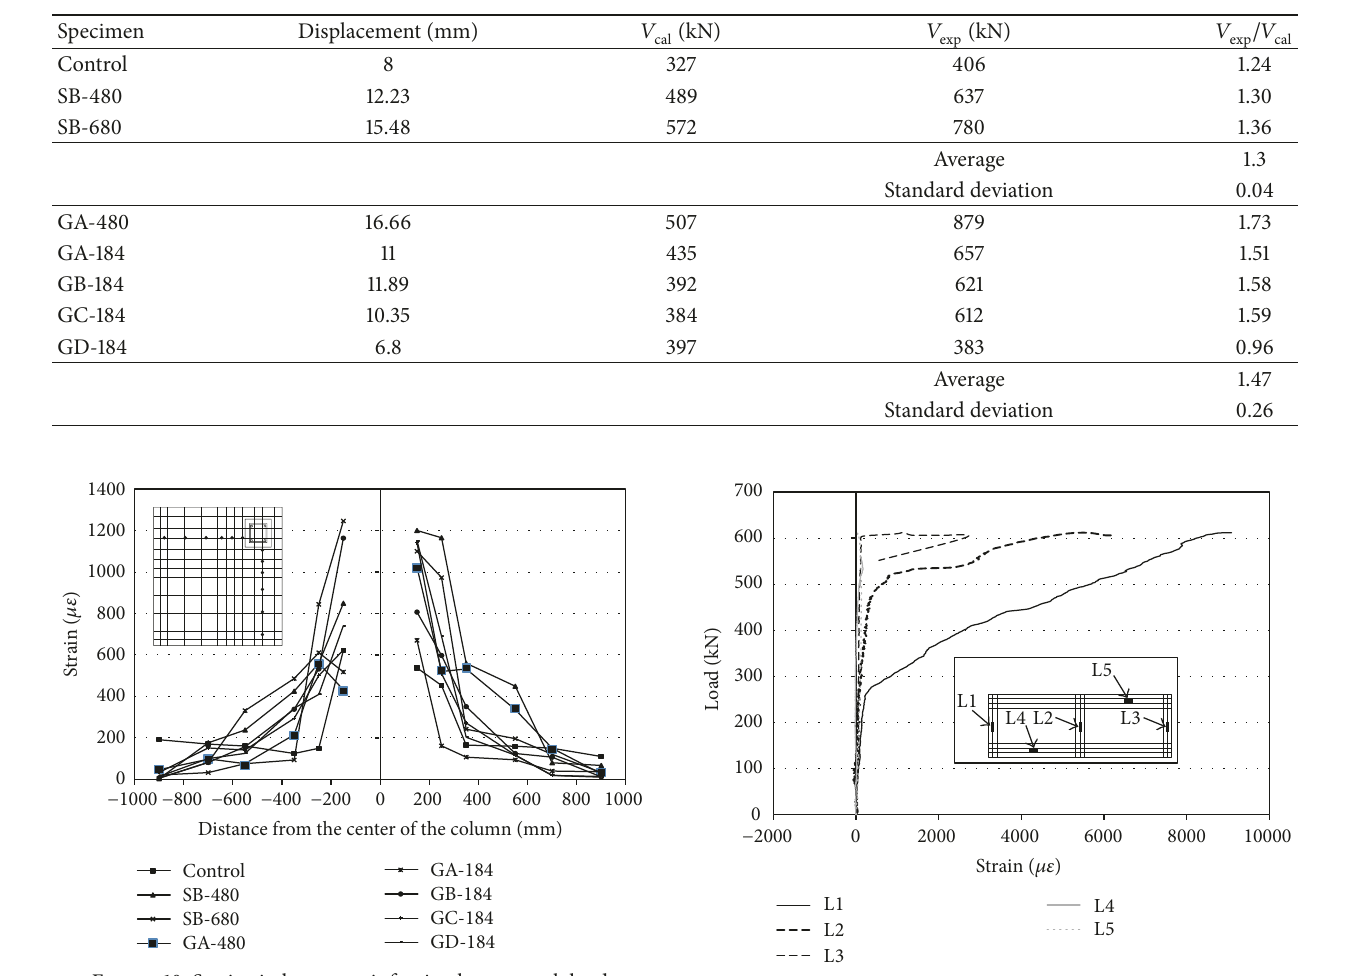
Figure 10: Strains in bottom reinforcing bars at peak load.